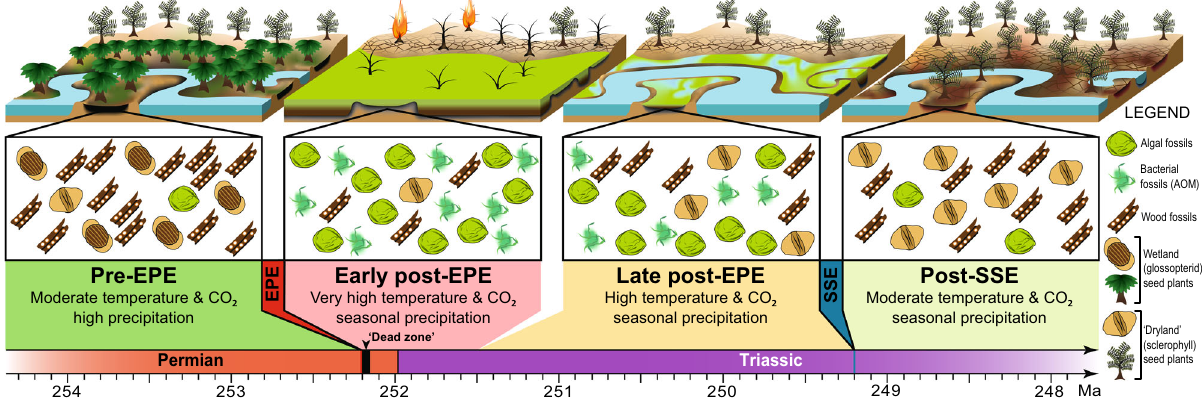
Fig. 4 Reconstructions of late Permian to Early Triassic continental ecological phases with representative organic microfossil assemblages. AOM = amorphous organic matter, EPE = end-Permian extinction event, Ma = millions of years ago, SSE = Smithian-Spathian climatic